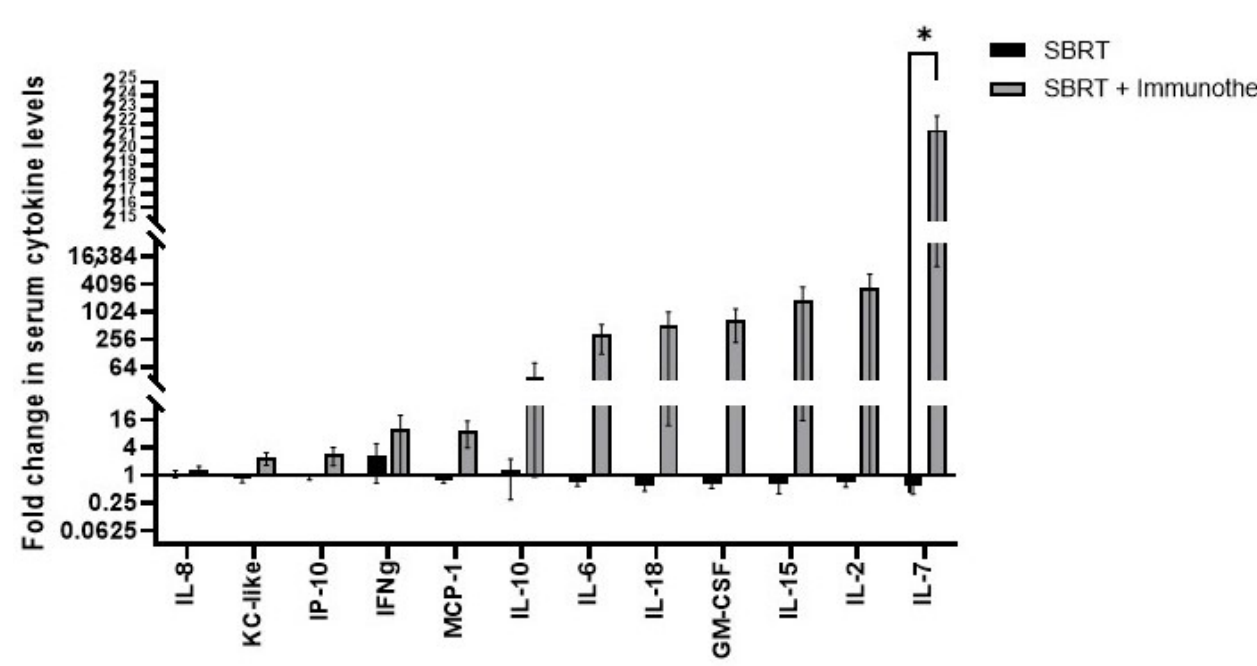
Figure 4. Serum cytokine responses associated with SBRT or SBRT and immunotherapy. Fold change in serum cytokine levels post-treatment relative to pre-treatment for dogs treated with SBRT or SBRT + immunotherapy. * p = 0.035 (SBRT n = 6, SBRT and immunotherapy n = 6).